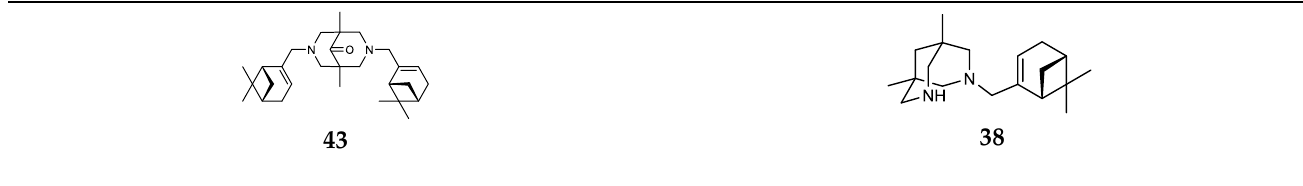
Table 4. Content of compounds 3 , 15 and 44 in reaction mixtures after 15, 30 and 60 min from the start of the reaction.